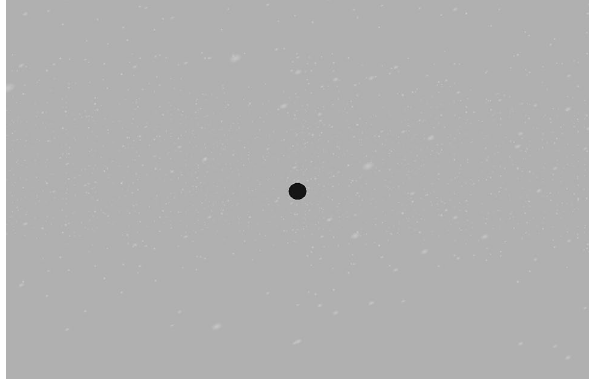
Figure 8. Example stimulus of Experiment 2, with